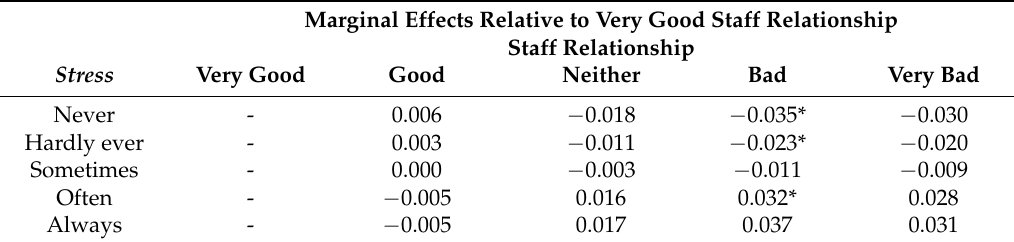
Table 6. Estimated marginal effect of relationship between staff on work-related stress.